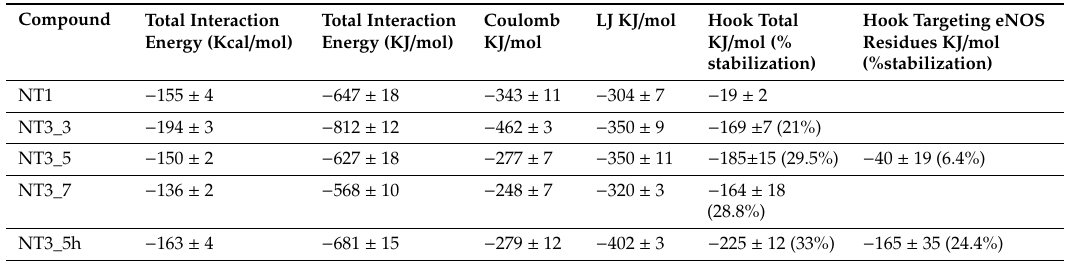
Table 3. Interaction energies of eNOS with NT1, NT 3_3, 3_7, and 3_5, decomposed in Coulombic and Lennard-Jones (LJ) contributions to the total interaction energy determined by Gromacs. Note the decrease in electrostatic interaction energies for the 2’ carboxylate as compared to the 3’ carboxylate in NT3_7 and NT3_5. Note that hook1 added interaction energy in its binding to eNOS (total hook interaction energy − 185 KJ / mol) but contributed only 6.4% ( − 40 KJ / mol) to the total interaction energy for binding specific variable residues. In contrast, most of the total interaction energy of hook 2 ( − 225 KJ / mol) with eNOS originated from specific interactions ( − 165 KJ / mol) with the targeted residues of eNOS. The values are mean values out of three